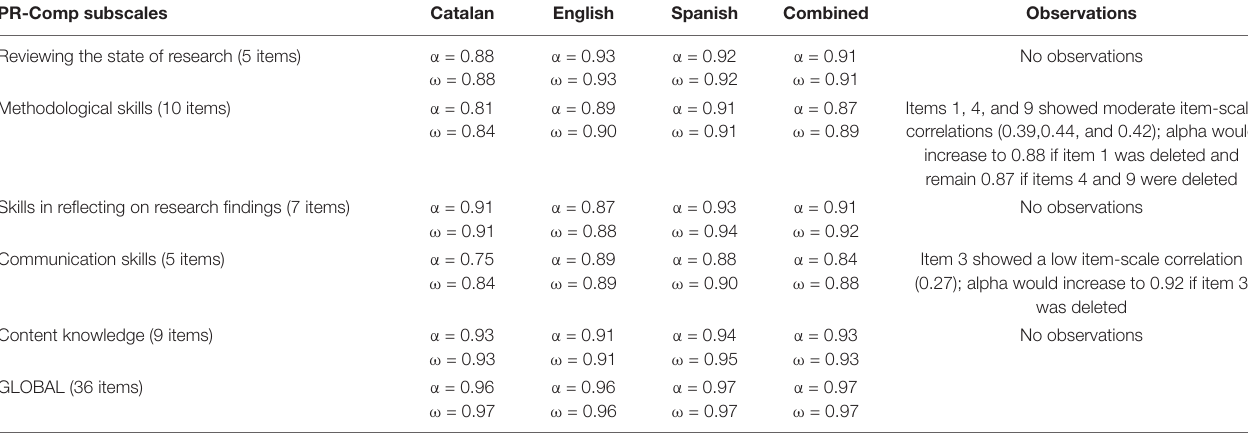
TABLE 4 | Reliability analyses of the PR-Comp subscales and instrument.